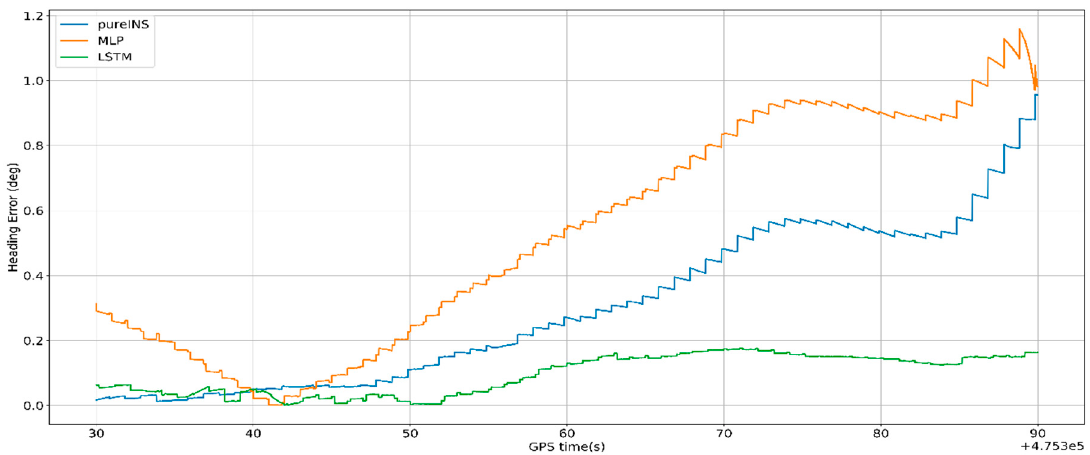
Figure 14. Heading errors of 60 s outages with di ff erent algorithms. Table 5. Max error of position, velocity, and heading during 60 s GNSS outages in di ff erent algorithms.